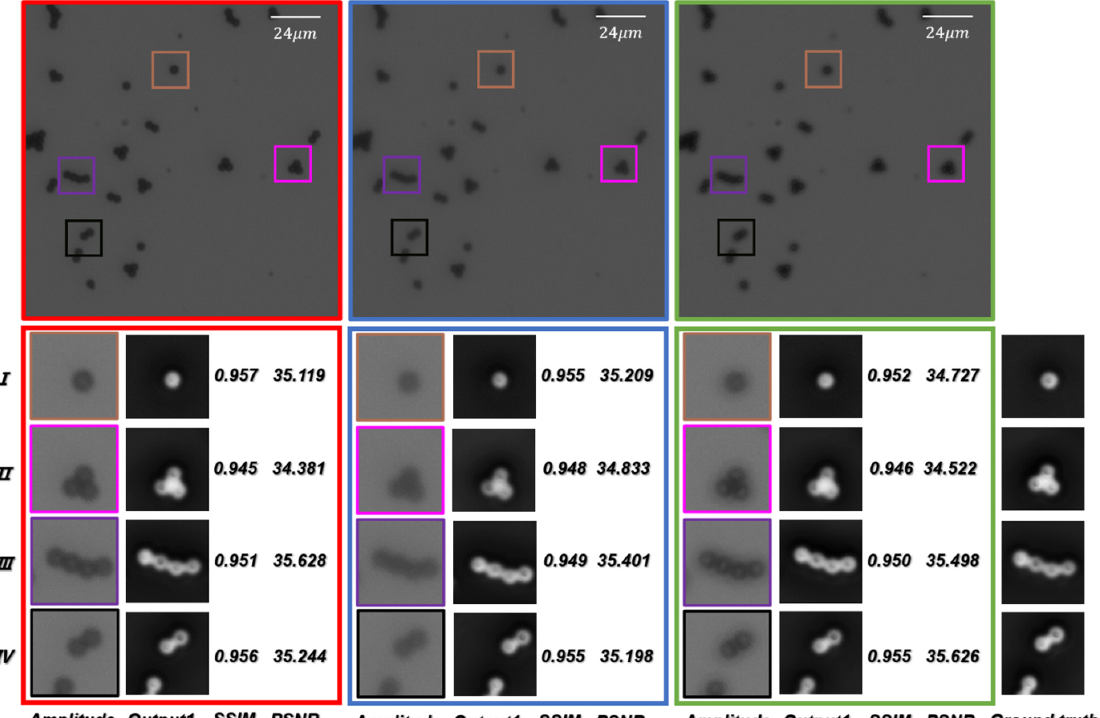
Figure 11. ( a ) Test results of the LR out ‐ of ‐ focus microscopic images. ( b ) Test results of the LR microscopic images with different contrast captured at different apertures of the concentrator.